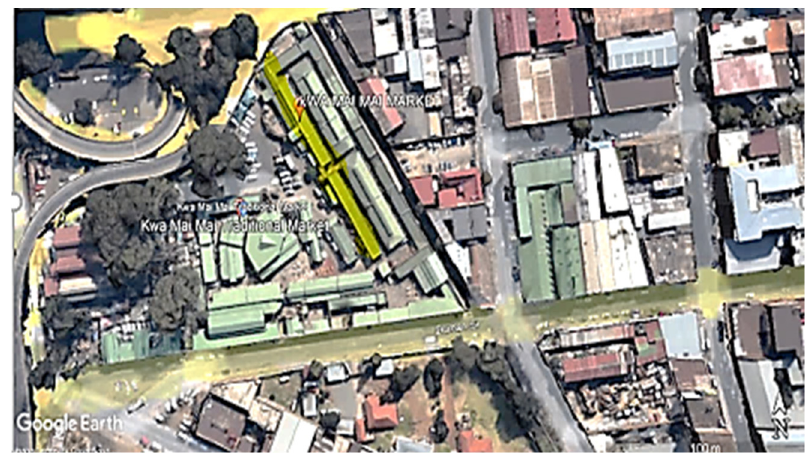
Figure 3. A map showing sampling location (HEG-2 market) in the inner city of Johannesburg [18].